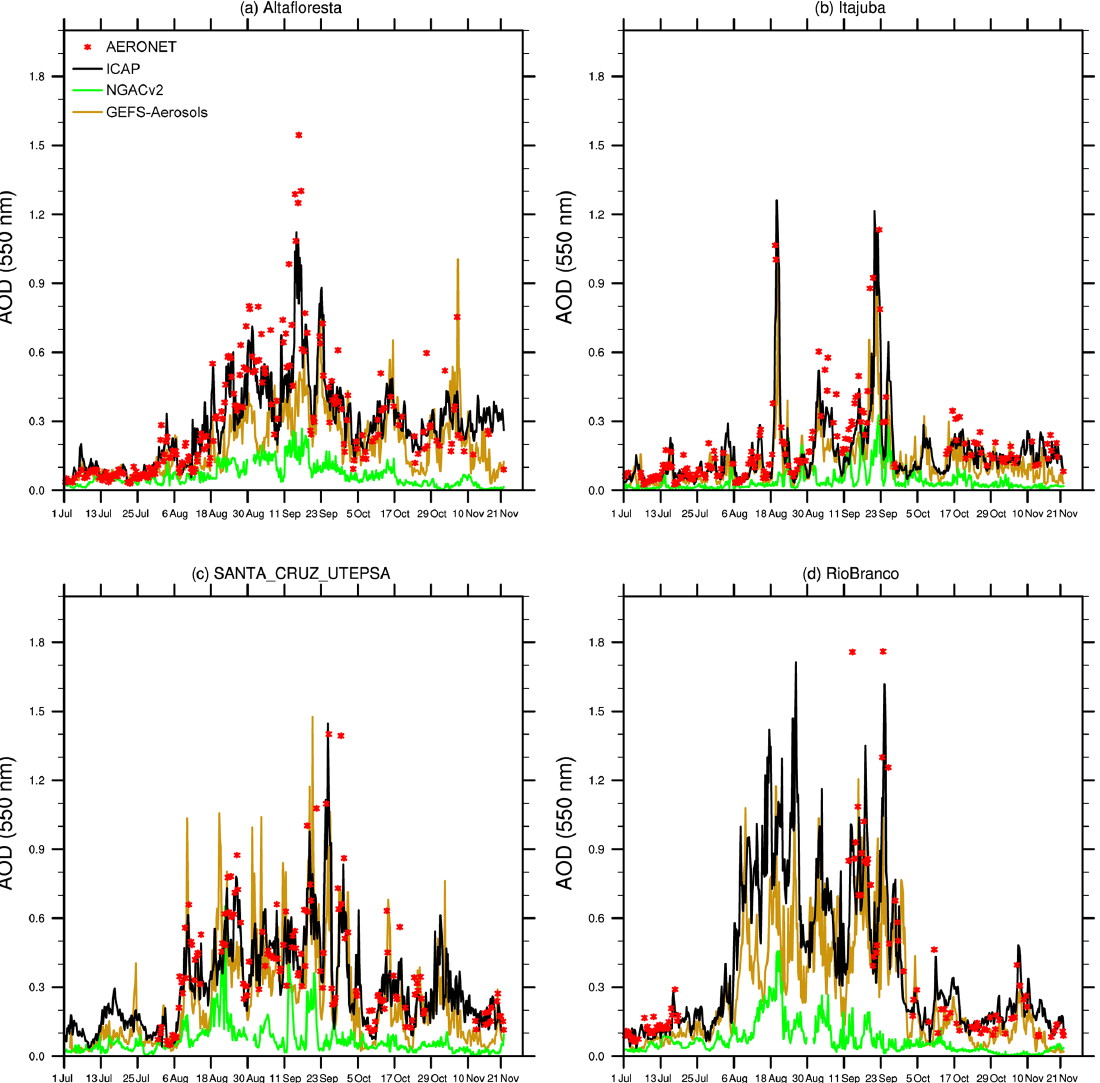
Figure 9. Day-1 AOD forecasts of GEFS-Aerosols, ICAP, and NGACv2 verified against AERONET sites in South America during 5 July–30 November